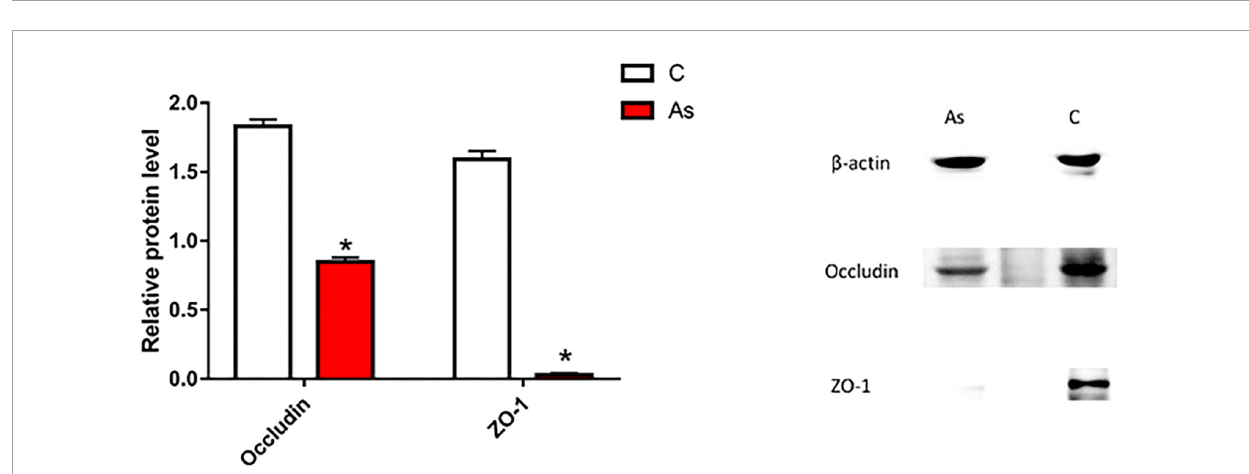
FIGURE4 Effect of arsenic (As) exposure on zonula occludens (ZO-1) and occludin protein levels. The data are presented as the means ± standard deviations of three parallel measurements. * P < 0.05 indicates a significant difference between the two groups.